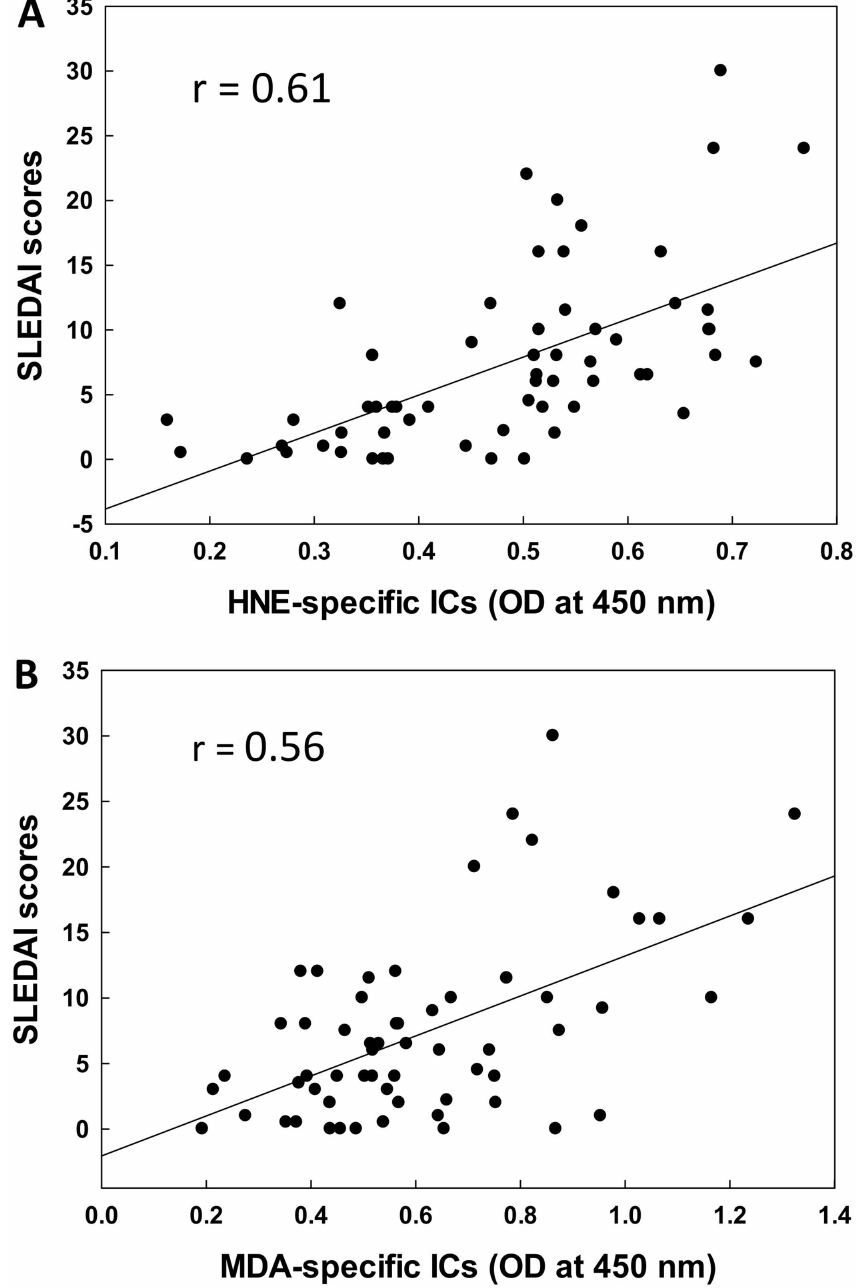
Fig 3. Correlation of serum HNE-specific ICs (A) or MDA-specific ICs (B) with SLEDAI scores. The correlationwas establishedby calculating correlationcoefficients between HNE- or MDA-specific ICs and SLEDAI